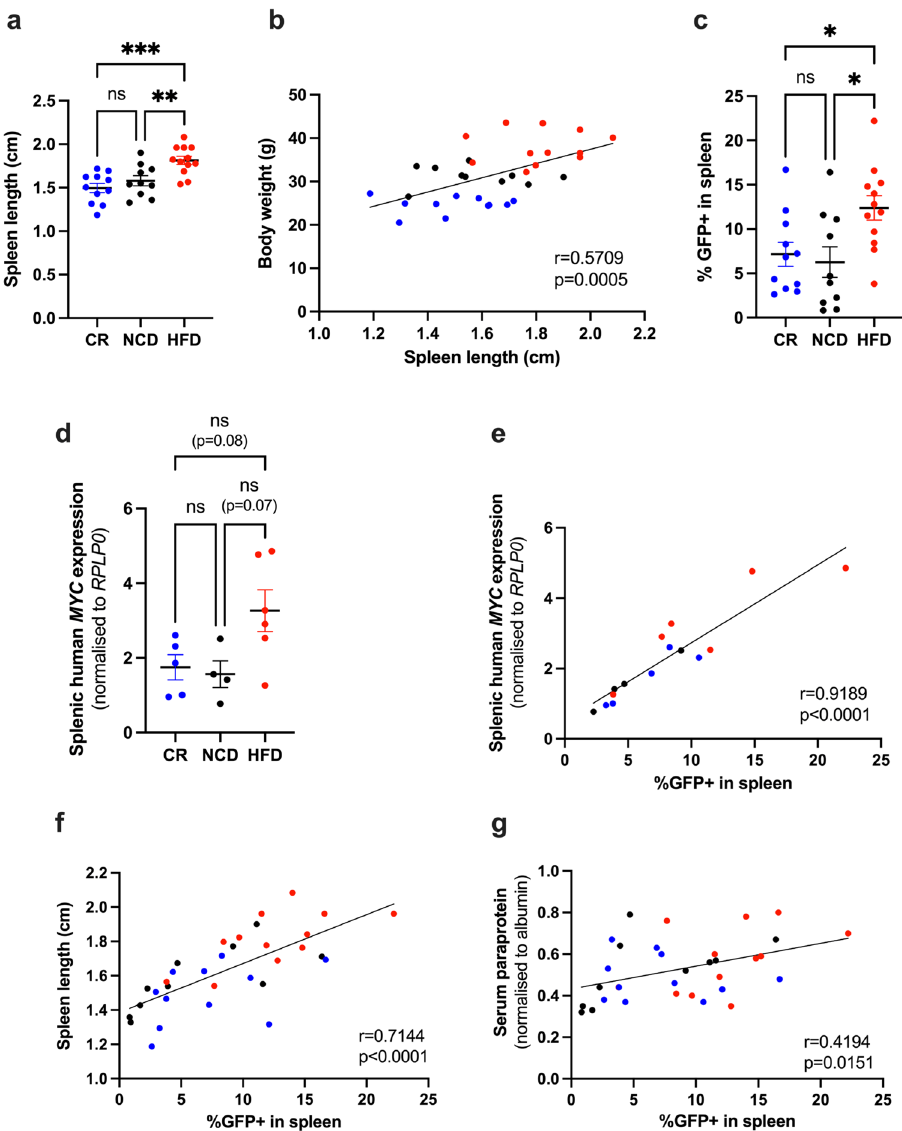
Figure 5. HFD promotes MM tumour growth in the spleen. ( a ) Spleen length, ( b ) Correlation between spleen length and body weight, ( c ) %GFP+ in spleen, ( d ) Splenic human MYC expression, ( e ) Correlation between %GFP+ in spleen and splenic human MYC expression, ( f ) Correlation between spleen length and %GFP+ in spleen, ( g ) Correlation between %GFP+ in spleen and serum paraprotein. Error bars SEM, ( a , c ) n = 10–12 mice/group, ( d ) n = 4–6 mice/group, Ordinary one-way ANOVA with Tukey’s multiple comparisons test, ( e ) Combined data (n = 15 mice) from n = 4–6 mice/group, ( f , g ) Combined data (n = 33 mice) from n = 10–12 mice/group, dot colours corresponds to diet group, blue dots: CR, black dots: NCD, red dots: HFD, correlation analysis, ns p > 0.05, *p < 0.05, **p < 0.01, ***p < 0.001, ****p <